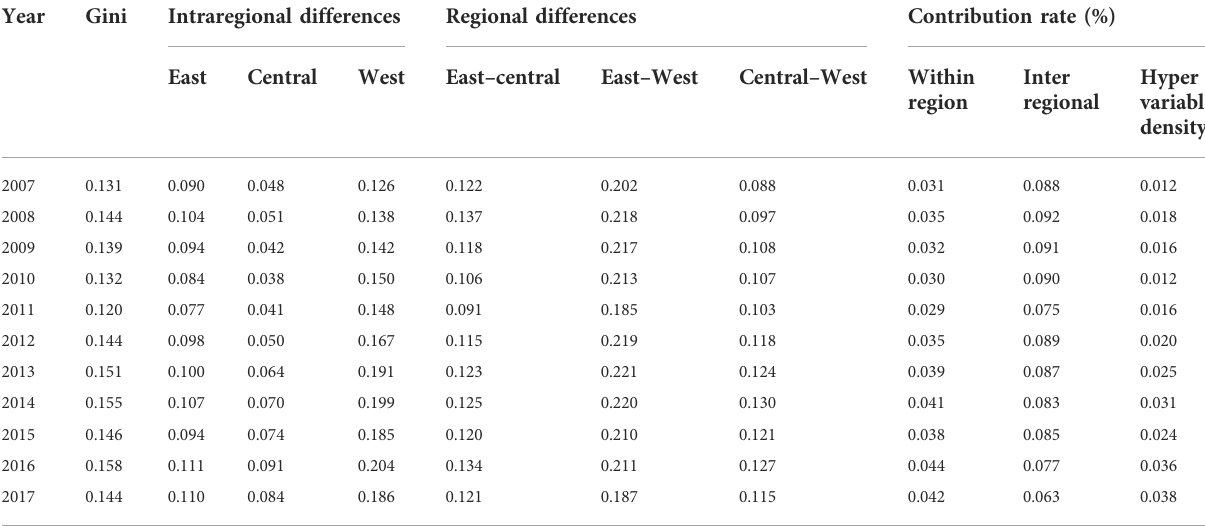
TABLE 5 Dagum Gini coef fi cient and its decomposition results of China ’ s industrial green transformation.